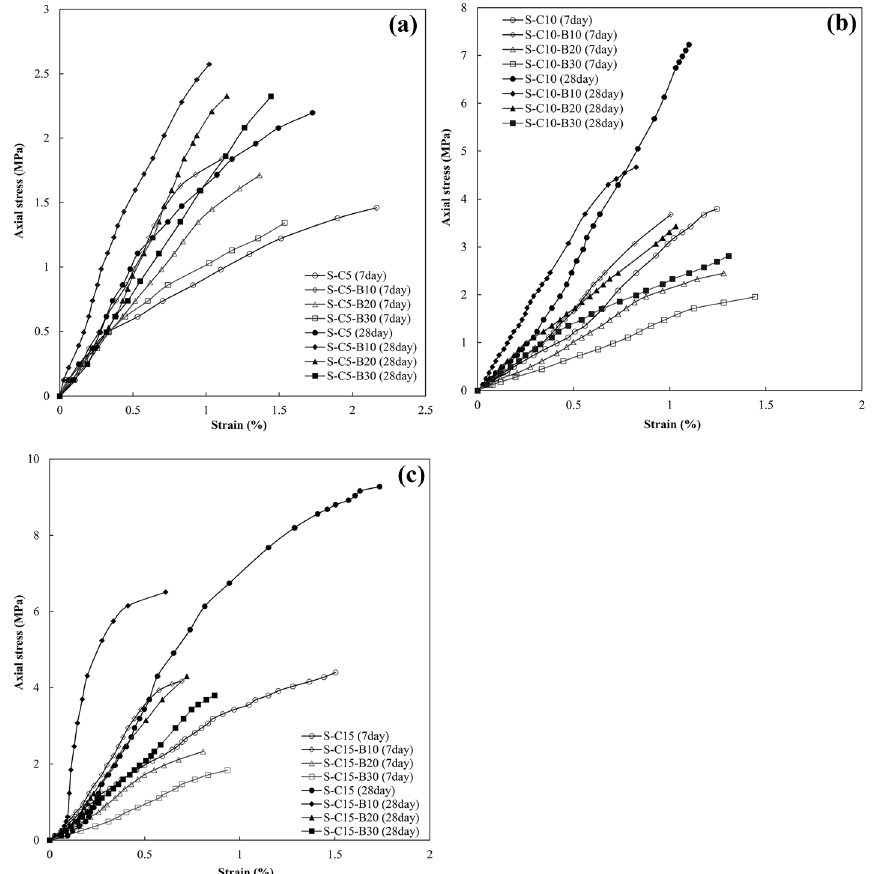
Fig. 10 The stress–strain curve for CSG mixtures containing bentonite additive and cured at both ages of 7 and 28 days: a the family of mixtures with 5% cement, b the family of mixtures with 10% cement, a the family of mixtures with 15%